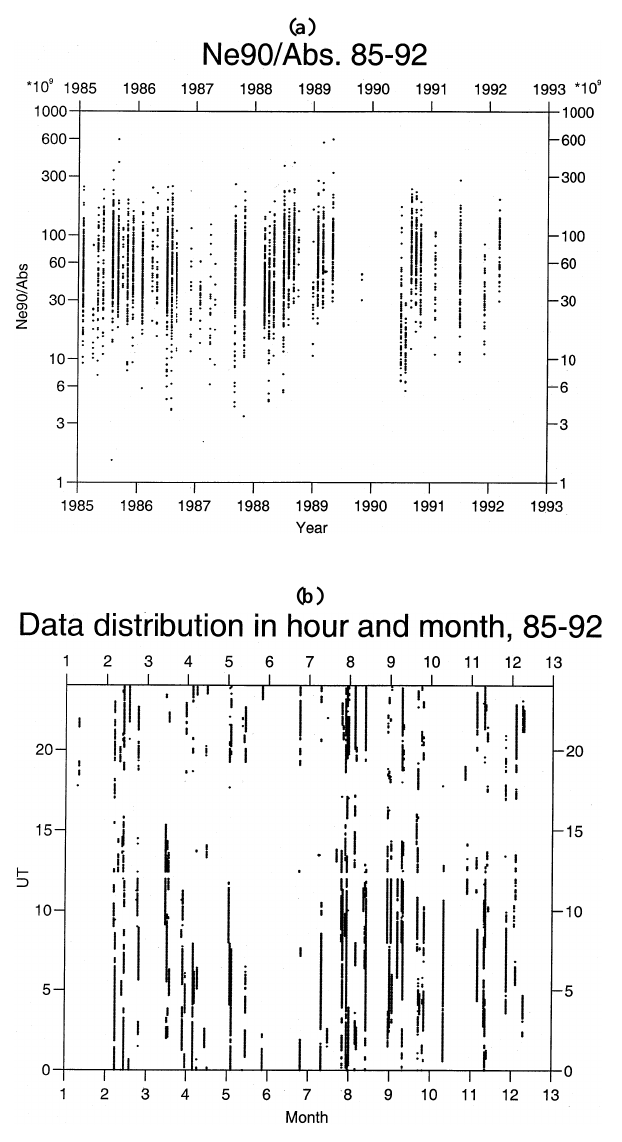
Fig. 2. Values of N e /A against time of day for (a) 90km and (b)